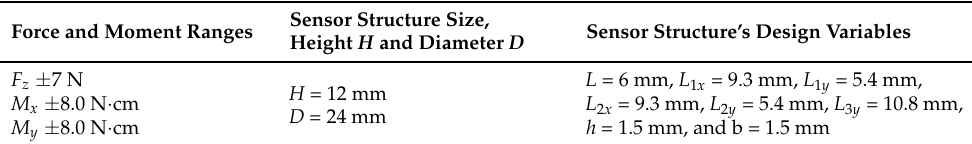
Figure 4. Measurable force and moment components on ( a ) the force/torque sensor and ( b ) simplified sensor structure model (of simply-supported beam).